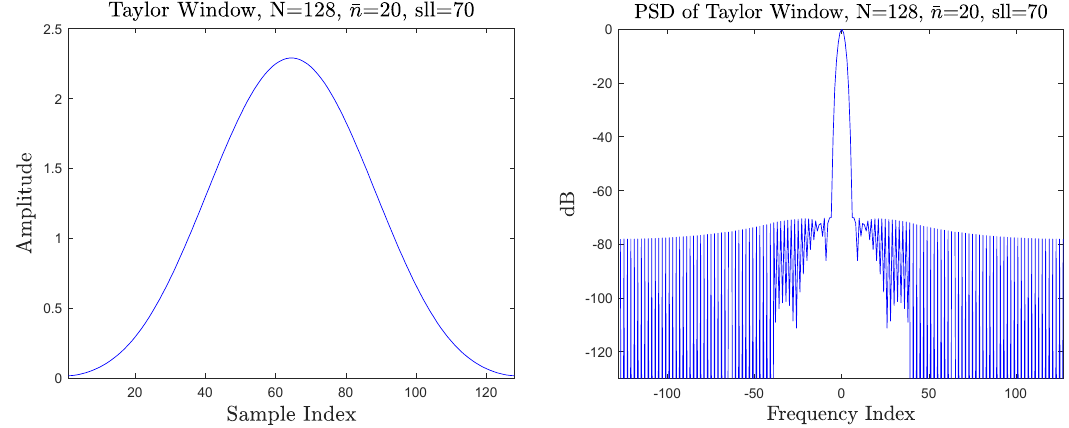
Figure 6. Taylor window and its power spectral density.